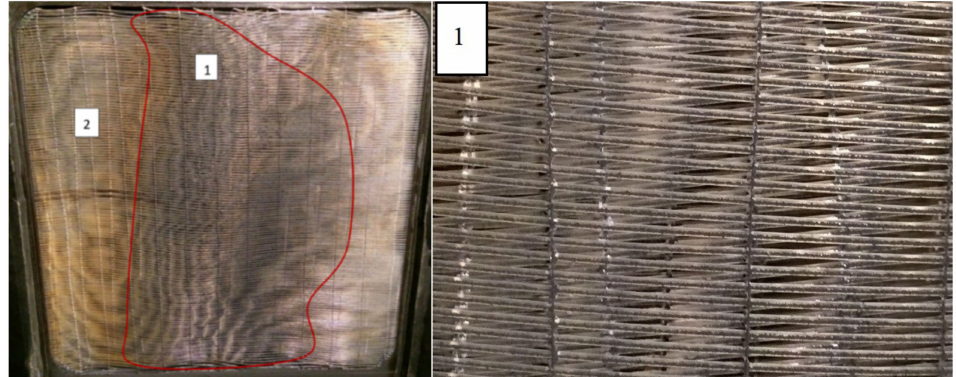
Figure 5. Heat exchanger surface after injection of 400 g m − 2 of test dust ( left ). There is seen that the fouling is not uniform across the heat exchanger cross-section. Fibers of zone 1 (see magnification on the ( right )) are more fouled with lot of deposit on the frontal part of the fibers, while the surface of the fibers in zone 2 has only separated